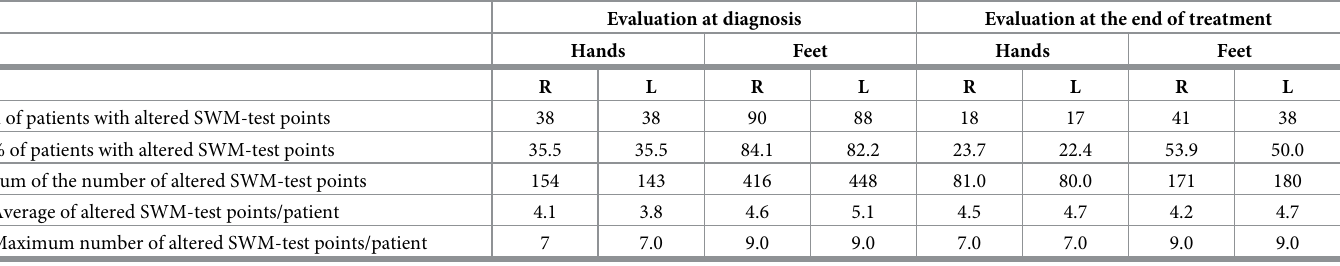
Table 6. The number and percentage of individuals with altered points in the hands and feet by SWM-test at diagnosis and at the end of treatment, and the sum, average and maximum number of altered points in the hands and feet at diagnosis and at the end of treatment. Evaluation at diagnosis